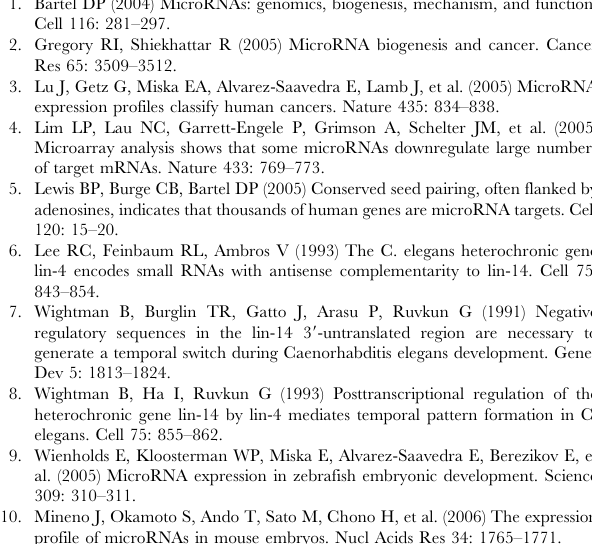
Table S3 miRNAs differentially expressed upon TS differenti- ation. miRNAs with expression changes of SNR + / 2 0.5 are shown.